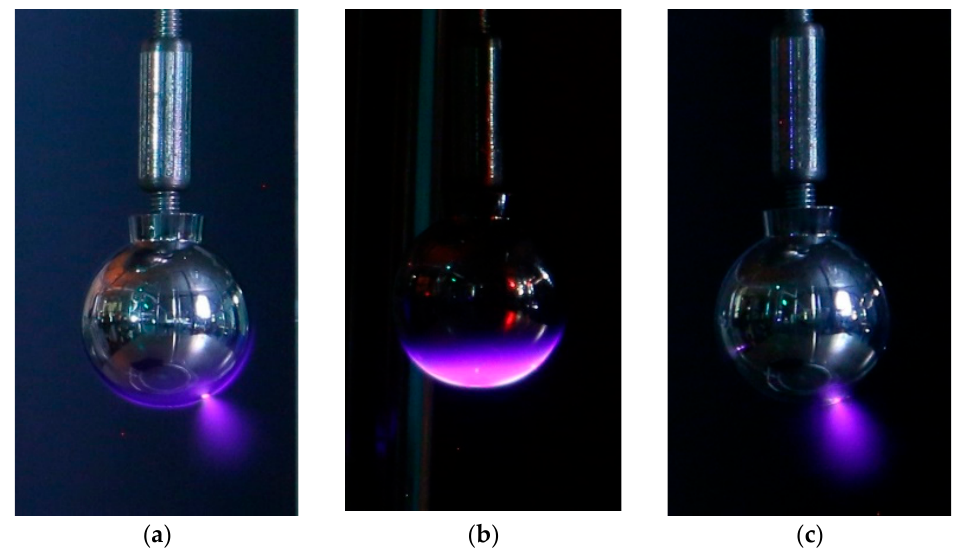
Figure 5. Sphere-plane gap. Photographs were taken with the DSLR camera. ( a ) Alternating current corona at 1 m. ( b ) Positive dc corona at 1 m. ( c ) Negative dc corona at 1 m.